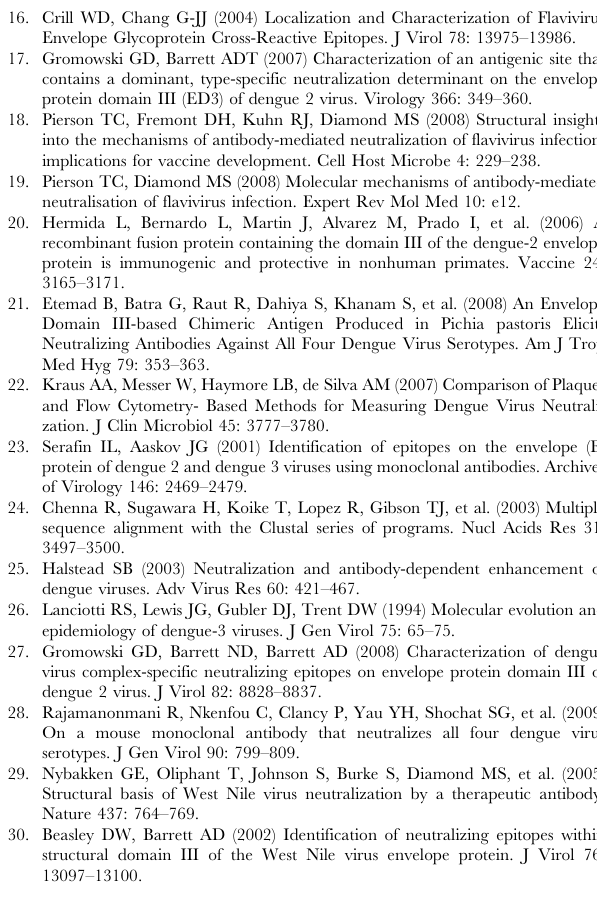
Figure S1 Phylogenetic tree of 175 DENV3 E protein sequences used to identify informative sites. A phylogenetic tree was generated using Bayesian inference to analyze the evolutionary relationship of 175 unique DENV3 envelope protein amino acid sequences that were available from Gen Bank at the time this study was initiated. The four known genotypes of DENV3 are indicated. The numeric values at the nodes represent Bayesian posterior probabilities and the distance scale bar represents 0.01 changes per site. Table S1 Binding of mouse MAbs 1A1-D2 to mutant DENV3 EDIII